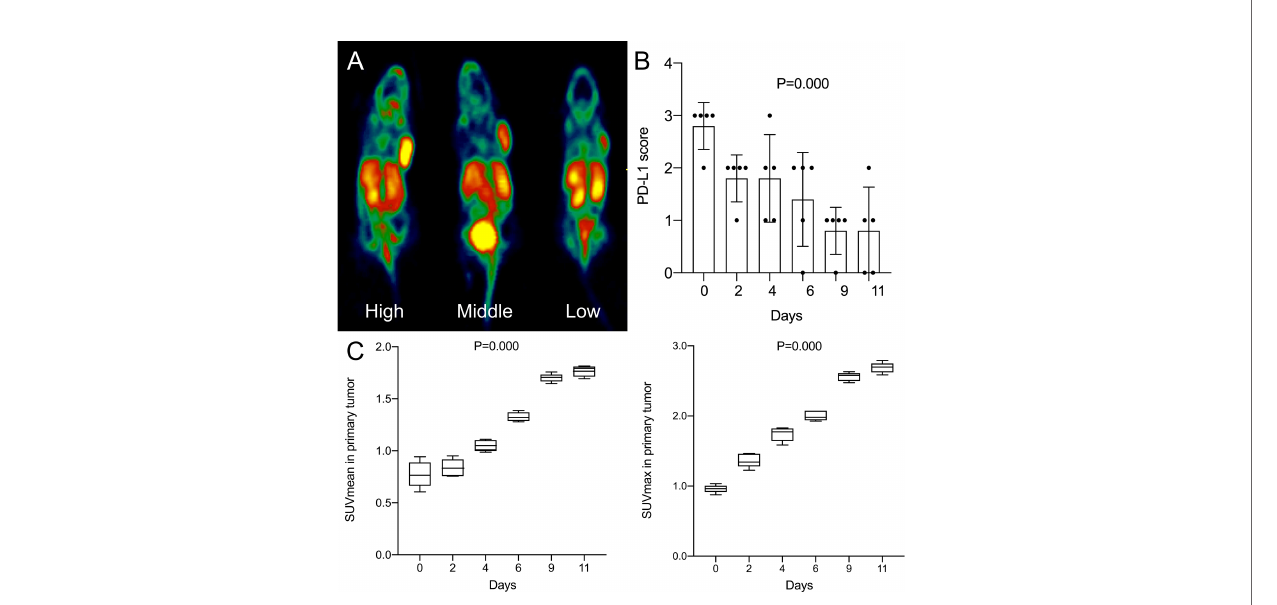
FIGURE 1 | (A) High, middle and low uptake of tumor in mice by 18 F-RGD PET/CT imaging; (B) Changes of tumoral PD-L1 expression score (6-step scoring system, ‘ Cologne Score ’ ) of mice with days; (C) Changes of SUVmean and SUVmax of mice with days. P < 0.05 is considered statistically signi fi cant.